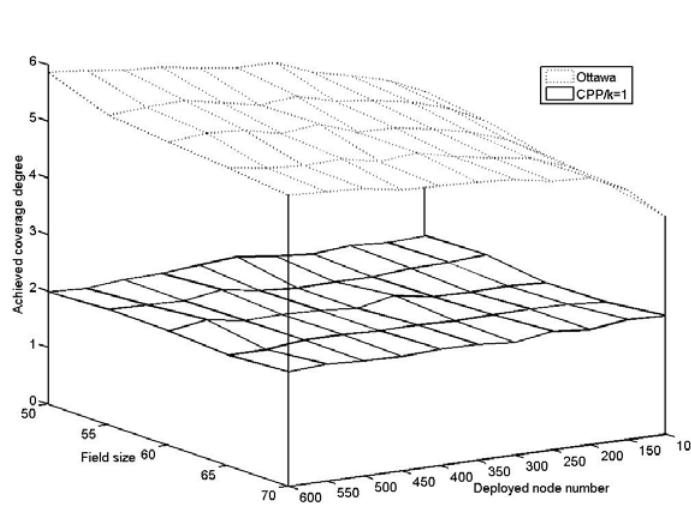
Figure 6. Achieved coverage